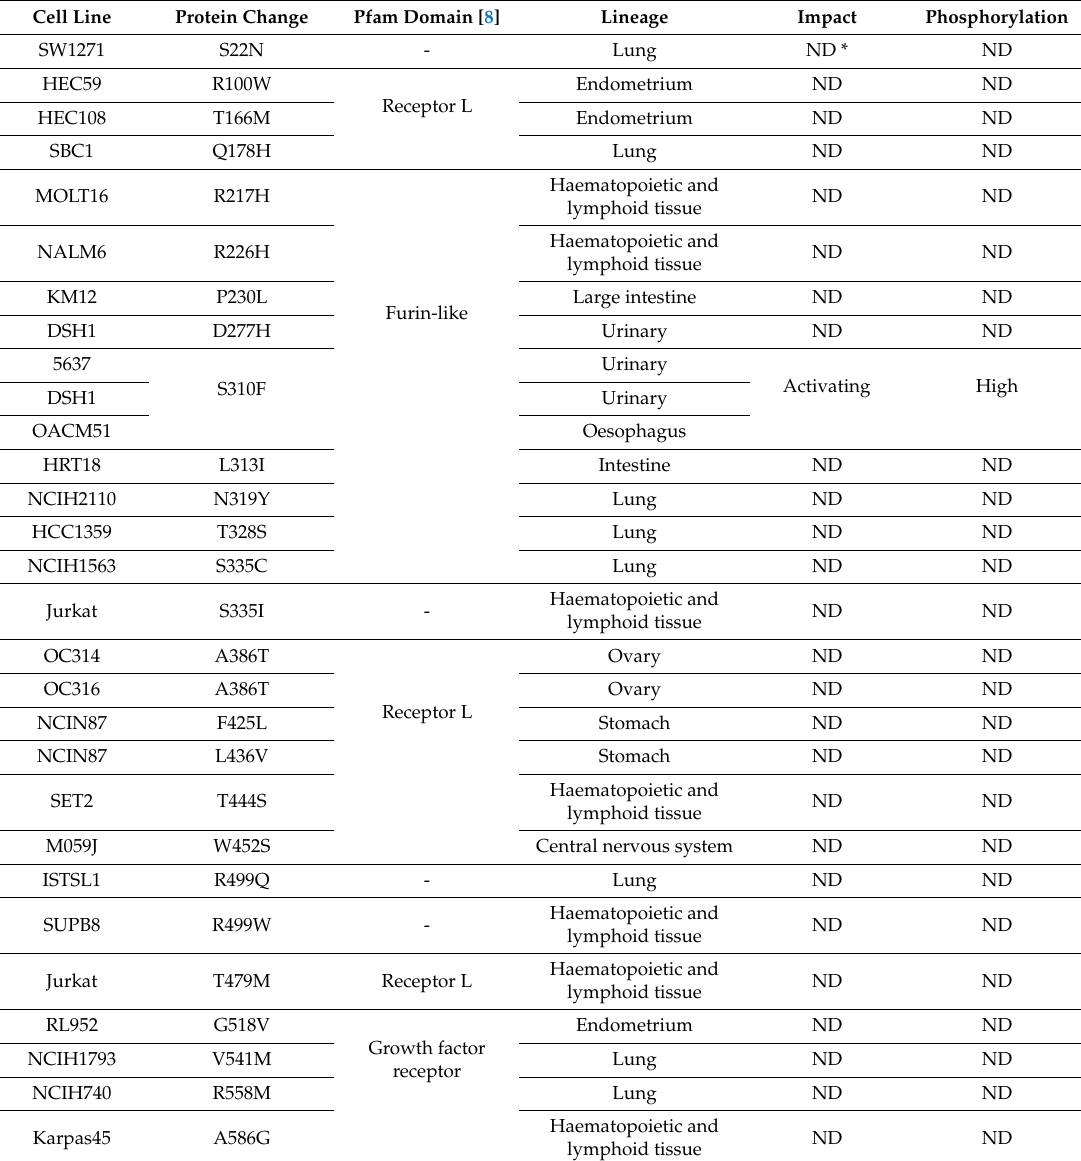
Table 2. HER2 extracellular domain mutations reported in cell